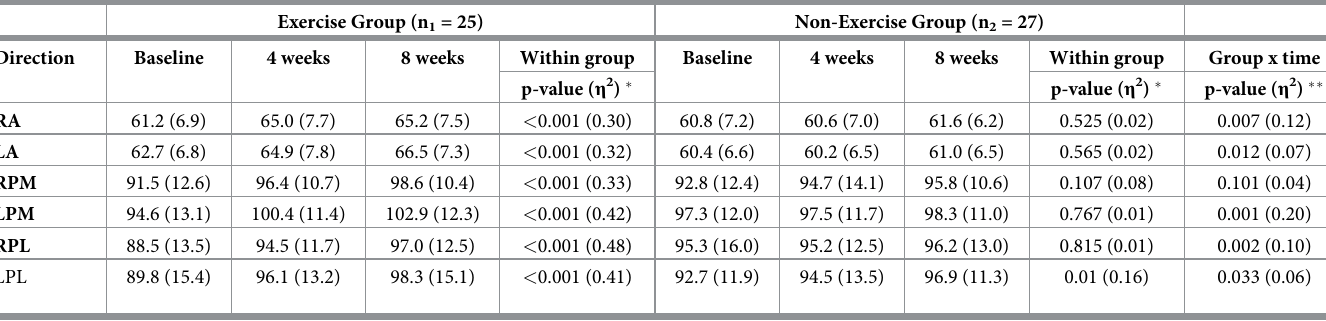
Table 3. Mean (SD) of reach distance by study group over time (N = 61).